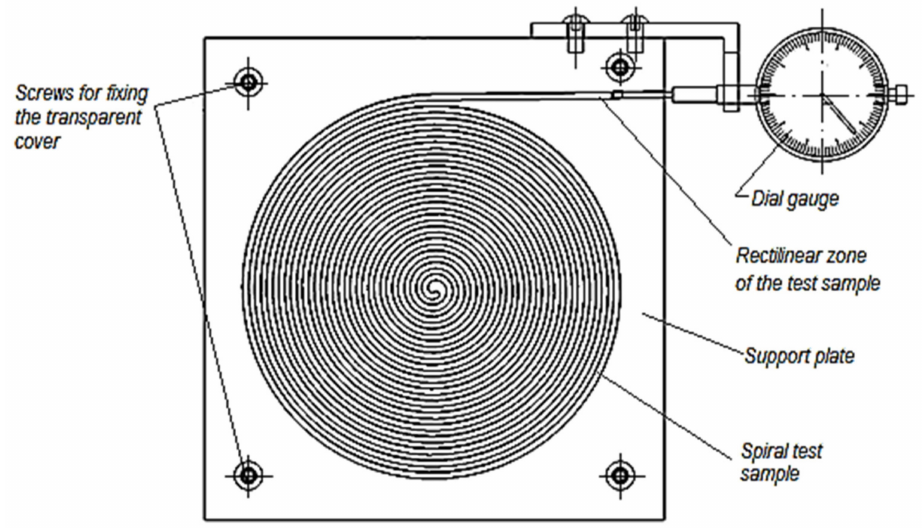
Figure 1. Schematic representation of the device for measuring the thermal expansion of a polymer spiral test sample in the variant involving a dial